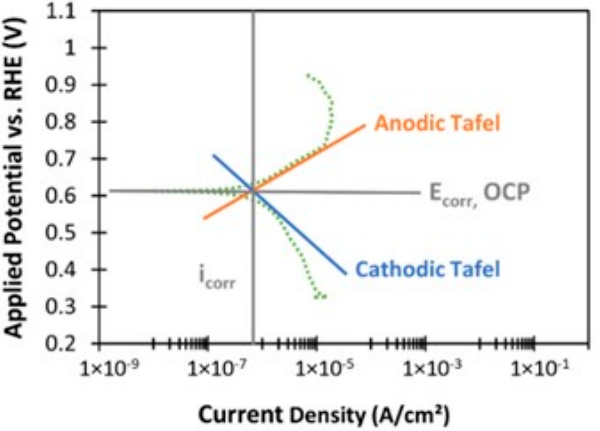
Figure 2. Example of a polarization curve. Green curve is the result of a potentiodynamic polarization experiment, orange and blue lines are the fit of the anodic and cathodic Tafel lines, respec- tively.